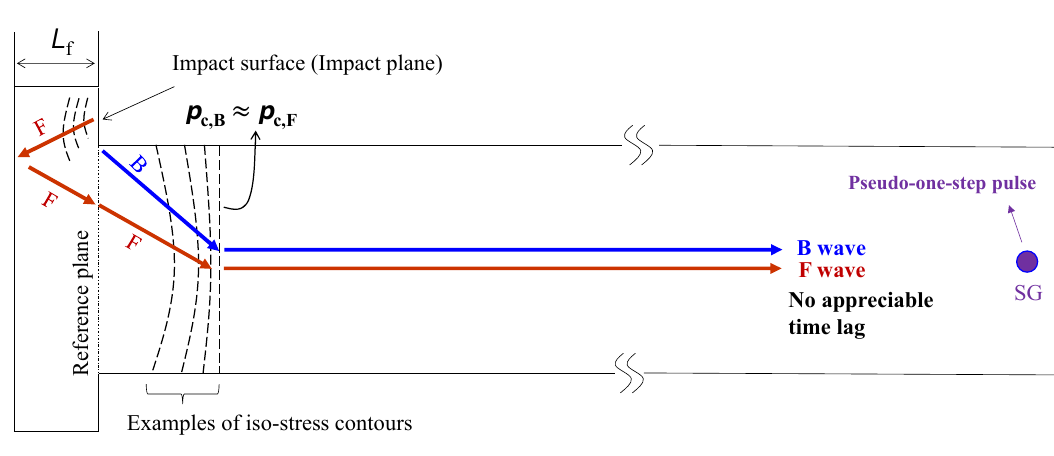
Figure 7. B and F waves when the flange length is short ( L f < ~ D b ), such that the critical plane for the F wave ( p c,F ) is positioned in the incident bar and not in the flange structure.